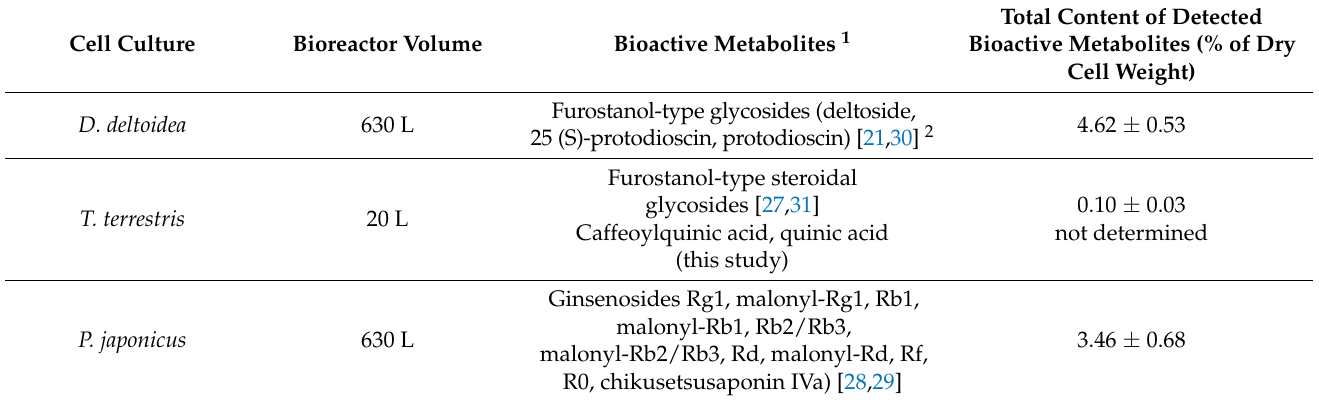
Table 3. Secondary metabolites detected in the suspension cell cultures of D. deltoidea , T. terrestris and P. japonicus grown in